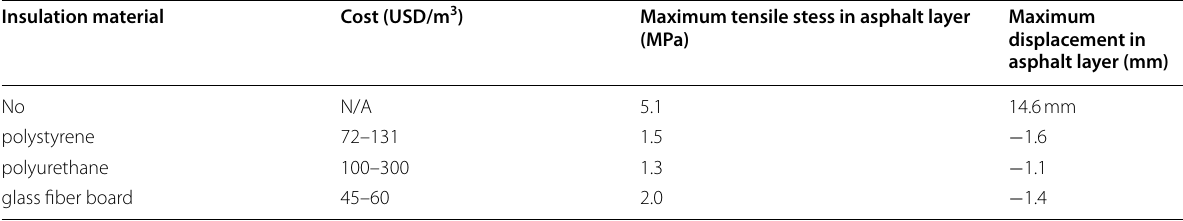
Table 2 The cost and effectiveness of the insulation